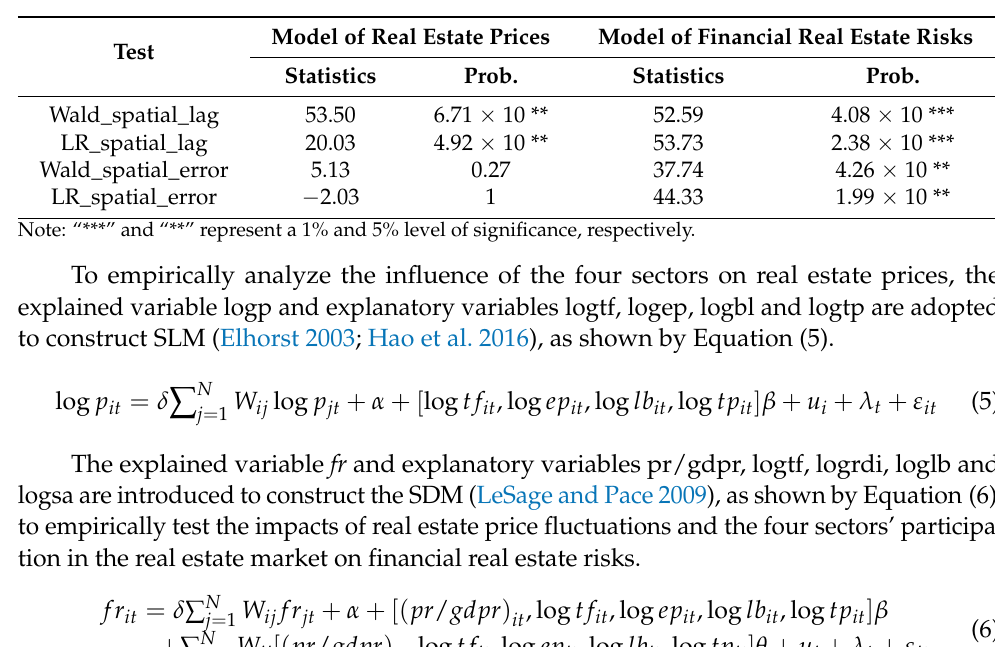
Table 3. Wald and LR test